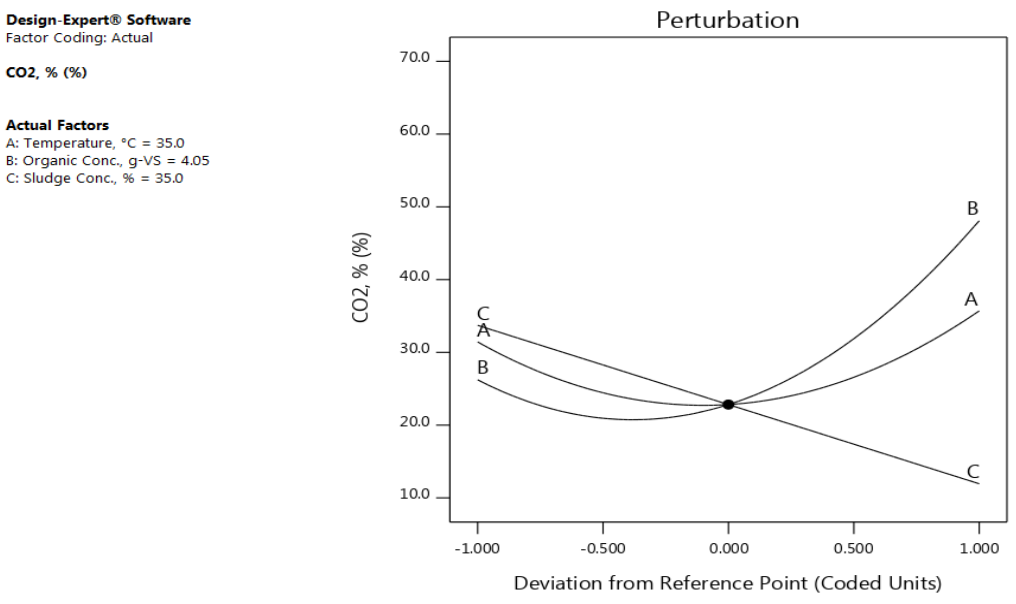
Figure 10. The Perturbation plot of the CO 2 % response.